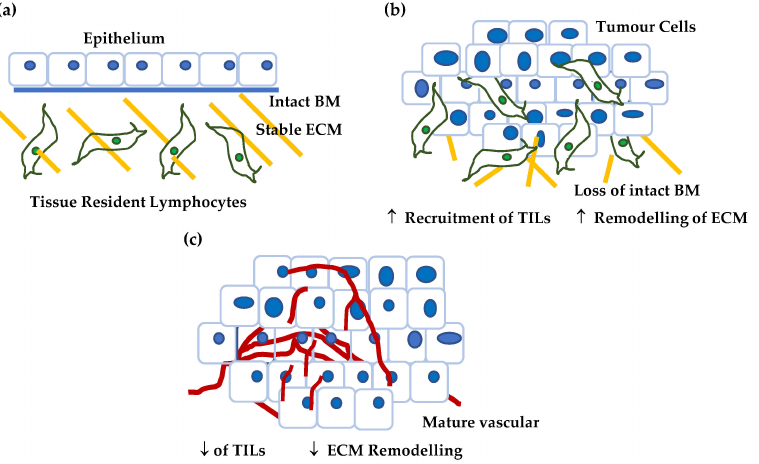
Figure 7. Proposed model for CSPG4 expression in cancer. ( a ) In normal, non-tumour tissue (in this case skin) the tissue is characterised by differentiated epithelium, low levels of tissue remodelling, a stable ECM, and quiescent tissue resident lymphocytes. Normal skin expresses little if any CSPG4. ( b ) As a tumour develops and grows the tissue is characterised by: (i) epithelium that becomes undifferentiated, as basement membrane barriers are broken down, (ii) ECM remodelling associated by tumour invasion, and (iii) increased hypoxia, a condition that is associated with the recruitment of tumour infiltrating lymphocytes (TILs). In addition, the number of tumour stem cells increases with the acquisition of markers of self-renewal and invasion (CSPG4, ITGA6, e.g., COL17A1 etc). This premetastatic lesion is characterised by higher CSPG4. ( c ) As the tumour develops further it acquires an established vascular network, and a stable tumour microenvironment where hypoxia is reduced and there is a reduction in TILs. There is a reduction in the number of cells capable of self-renewal as a proportion of the tumour mass. At this later stage CSPG4 levels are